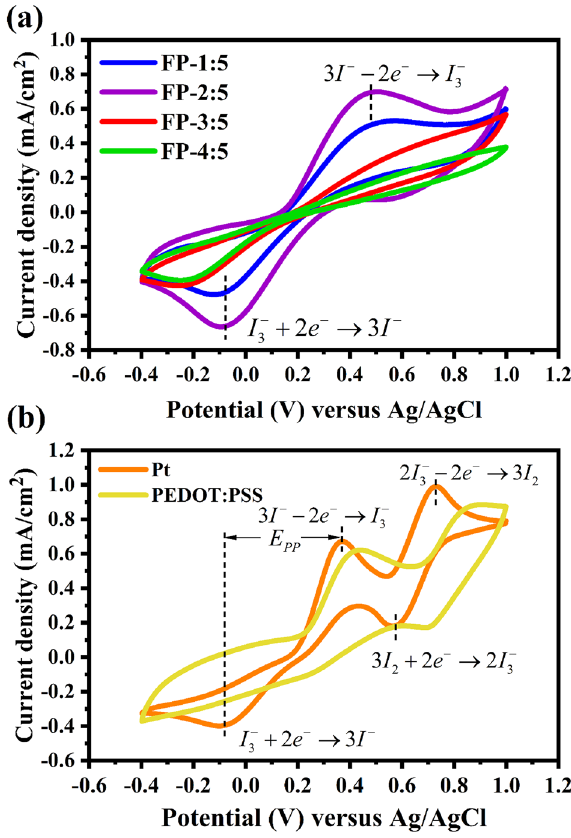
Figure 8. CV curves of ( a ) FP, ( b ) Pt and PEDOT:PSS counter electrodes.